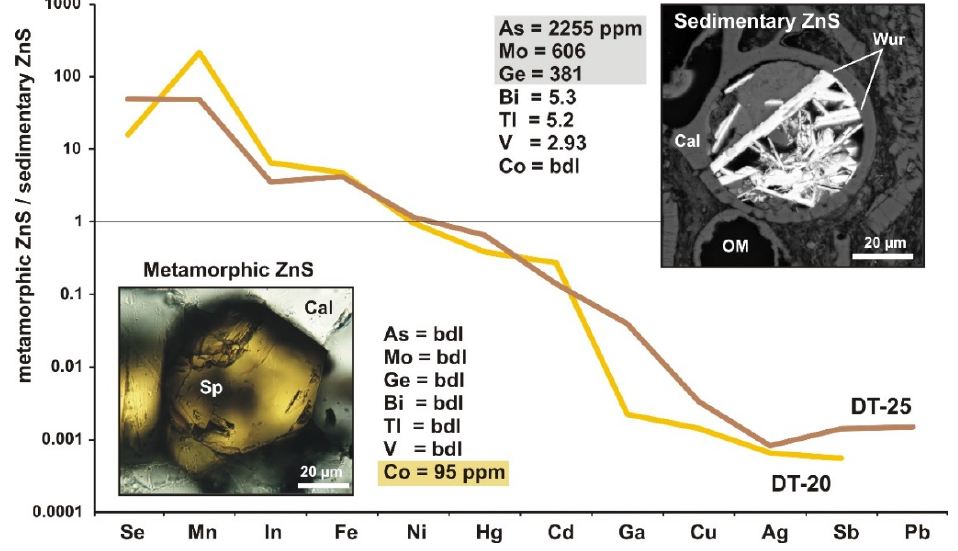
Figure 15. Trace element patterns of combustion metamorphic ZnS (sphalerite), normalized to its authigenic sedimentary precursor ZnS (würtzite and sphalerite); based on LA-ICPMS (Table 3), SEM- EDS and EPMA (Table 2) data. Cal = calcite, OM = organic matter, Sp = sphalerite, Wur =